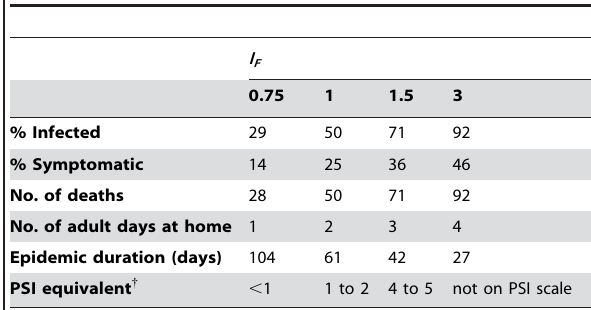
Table 3. Pandemic outcomes for unmitigated epidemics